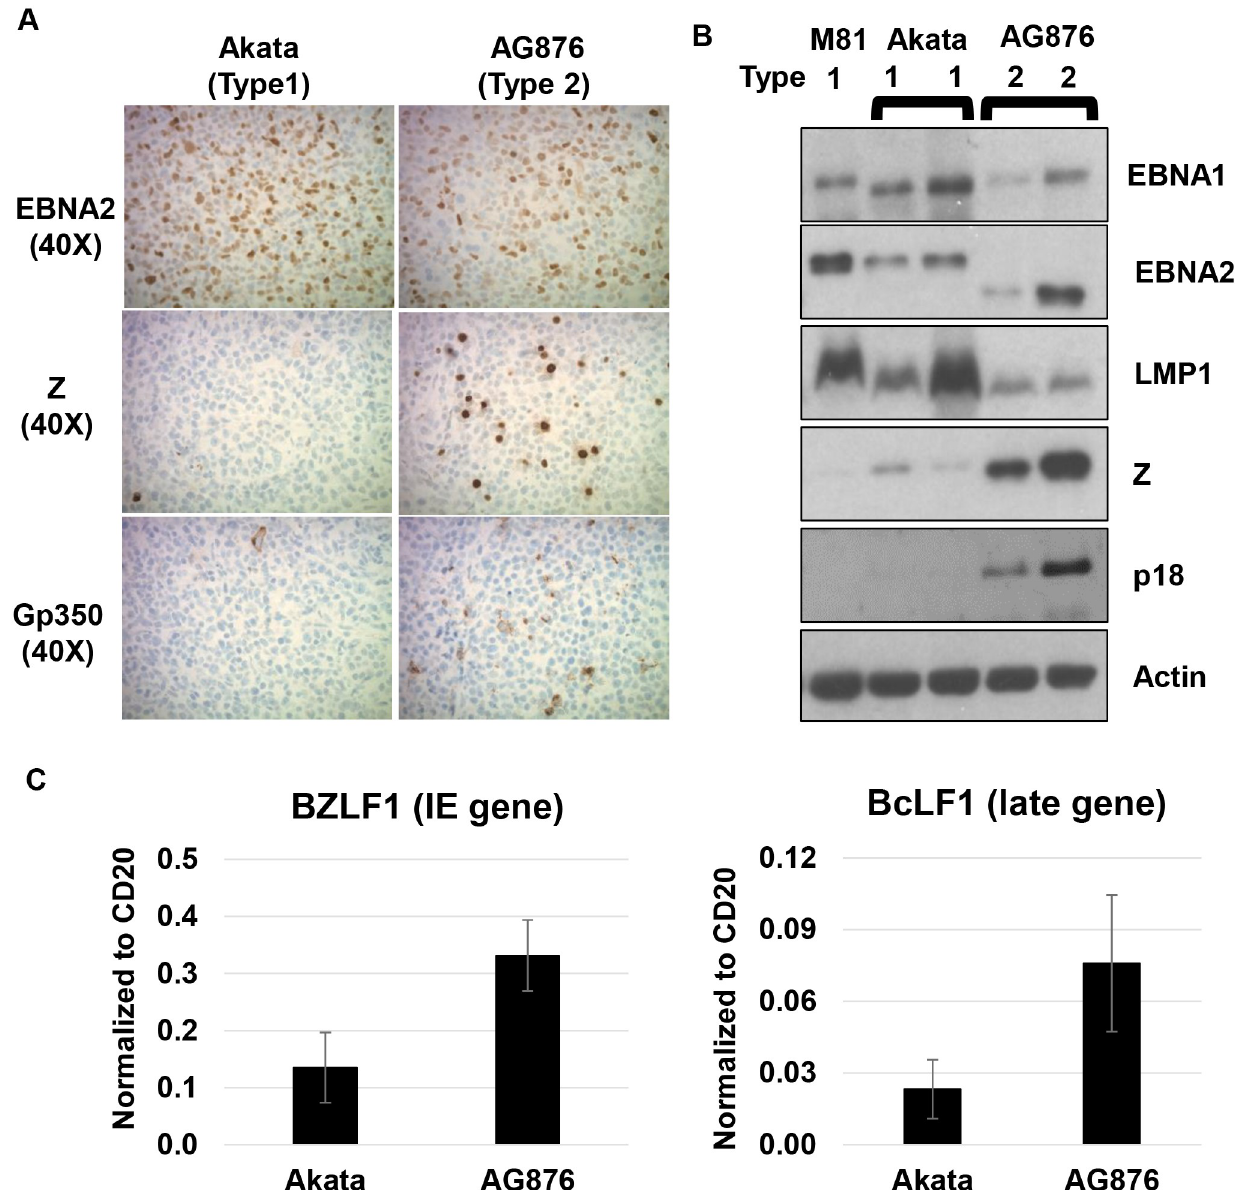
Fig 3. T2 EBV-infected lymphomas have elevated lytic infection compared to T1 EBV-infected lymphomas. A) IHC analysis using antibodies against EBNA2 (EBV latency protein), BZLF1 (Z) (immediate-early lytic protein), and gp350 (late lytic protein) was performed as indicated. B) Immunoblot analysis of proteins isolated from T1 and T2 lymphomas was performed using antibodies against EBNA1 (EBV latency protein), EBNA2, LMP1 (EBV latency protein), Z, p18 VCA (late lytic protein), and actin. C) RNA isolated from T1 and T2 EBV-induced lymphomas was subjected to qPCR analysis using primers that recognize the immediate early lytic gene BZLF1 and late lytic gene BcLF1 from both T1 and T2 EBV; results were normalized to the level of the cellular B-cell specific CD20 transcript.